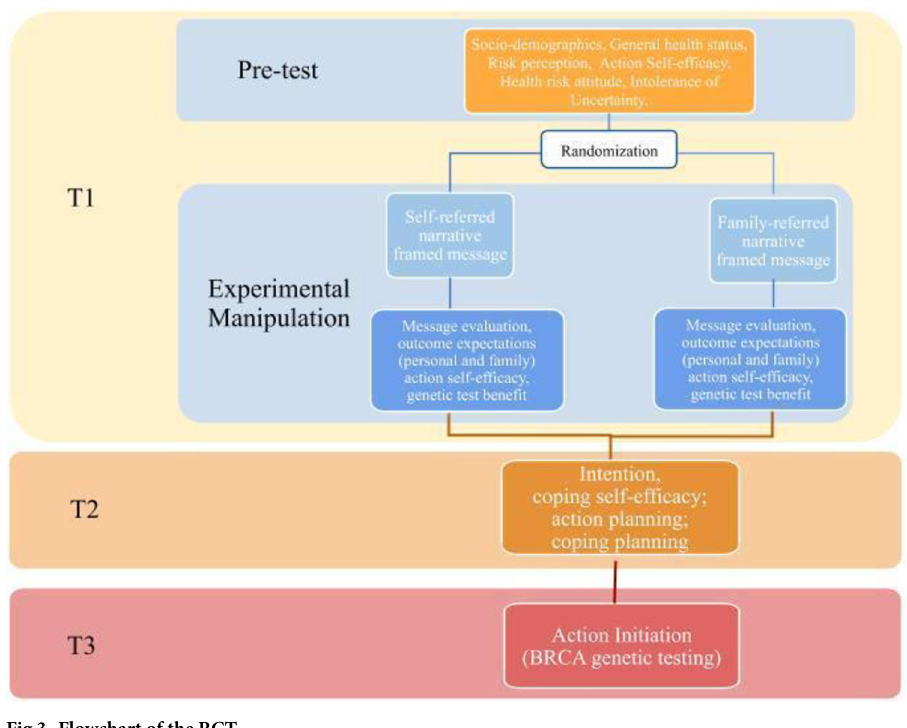
Fig 3. Flowchart of the